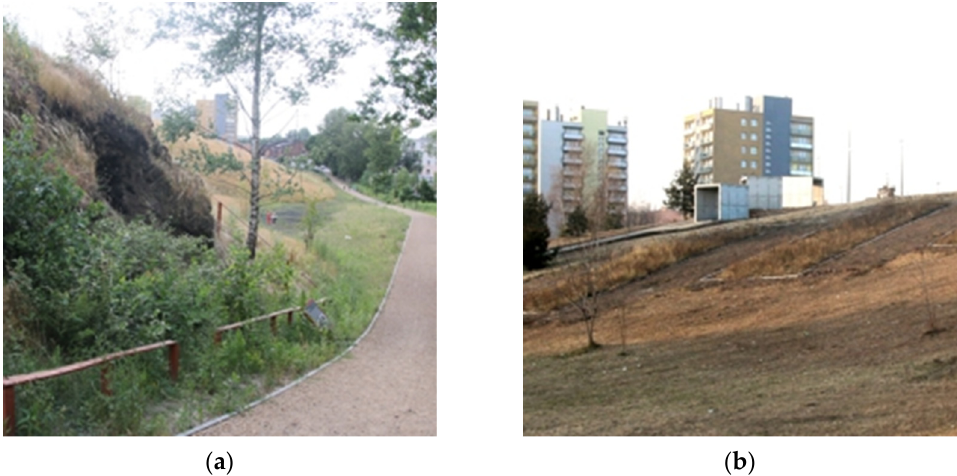
Figure 8. Fragments of the natural plant cover left to allow the process of natural succession and to contribute to the enrichment of the local flora, also as traces of Antonia Hill’s natural history: ( a ) A fragment of the slag cliff with metallophytes as a rock witness to the history of the place; ( b ) the metallophyte spots highlighted by concrete curbs on the south slope.